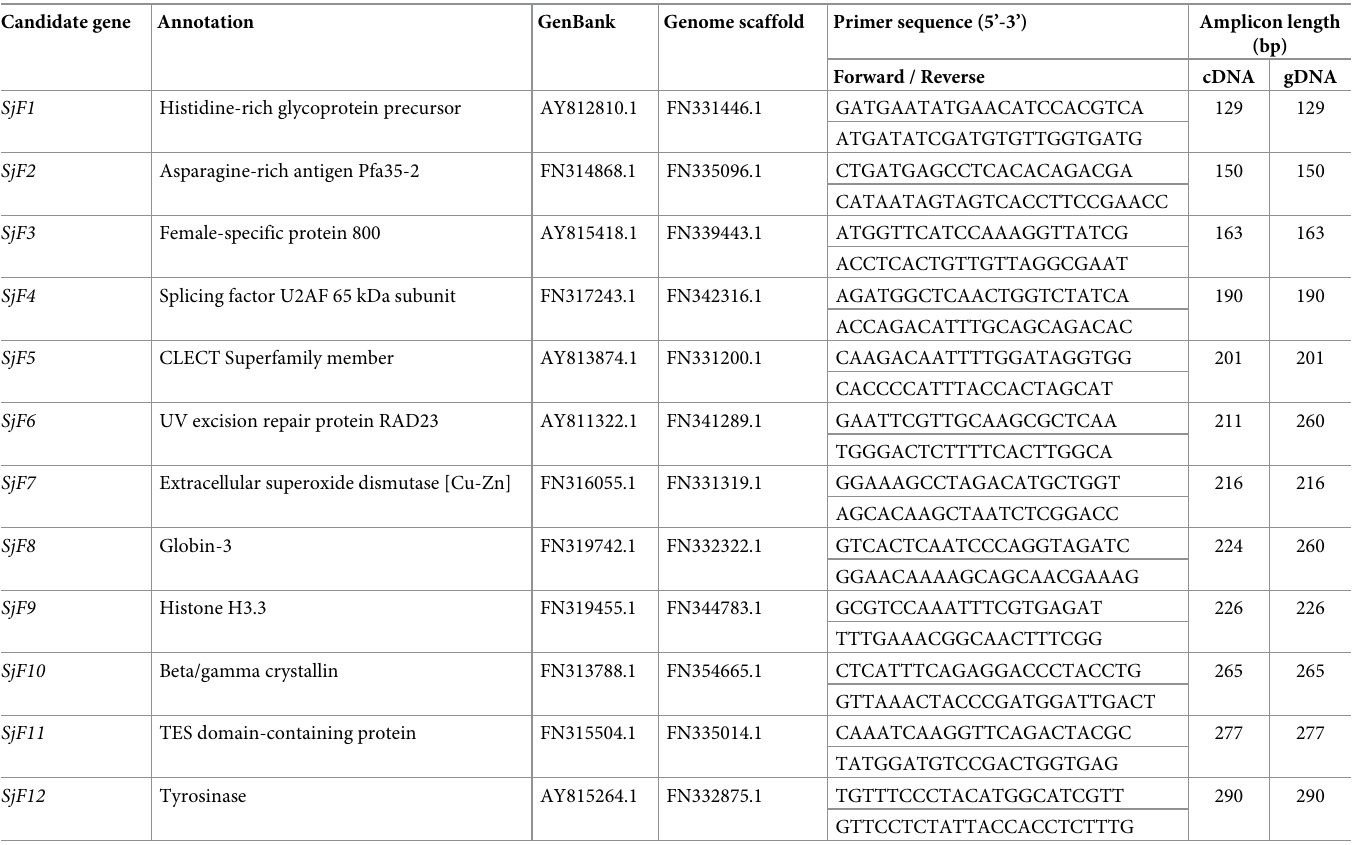
Table 1. Summary information of 12 candidate genes for sex biomarker